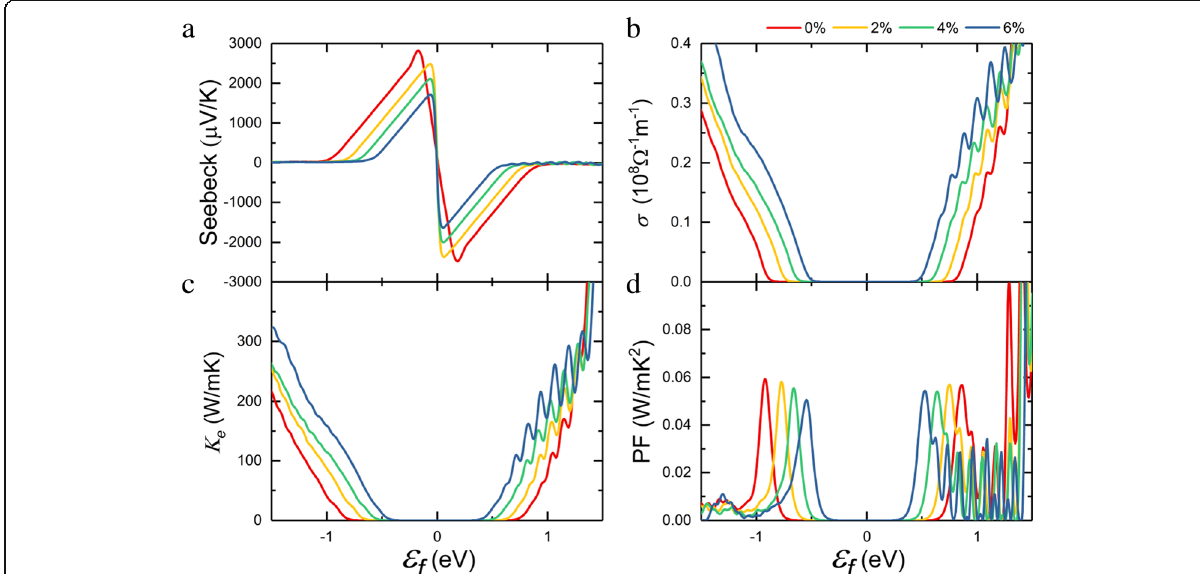
Fig. 3 a Seebeck coefficient, b electrical conductivity, c electronic thermal conductivity, d power factor of the monolayer InSe as a function of chemical potential at 300 K when the different biaxial strain is